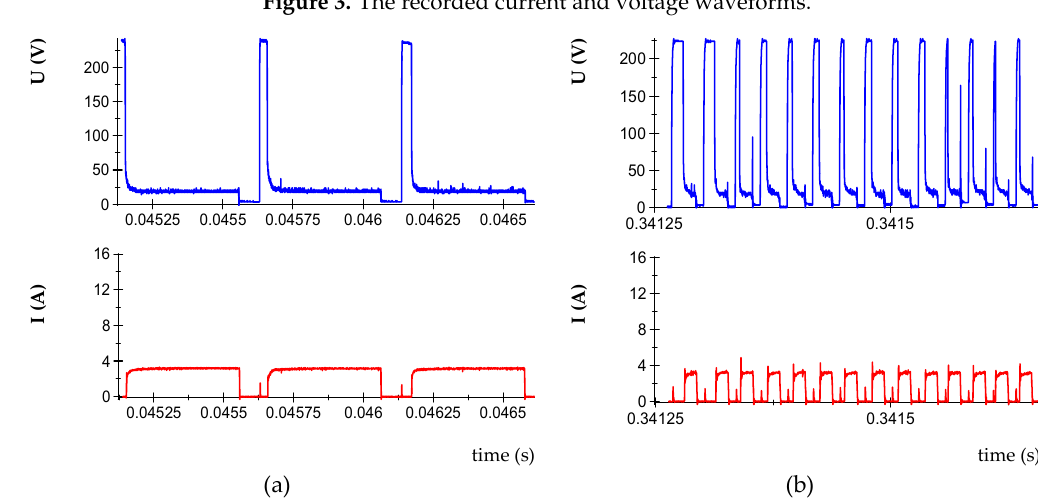
Figure 4. The recorded voltage and current waveforms for the following parameters: ( a ) U c = 25 V, U z = 230 V, I = 3 A, t on = 400 μs, t off = 100 μs; ( b ) U c = 25 V, U z = 230 V, I = 3 A, t on = 13 μs, t off = 13 μs.